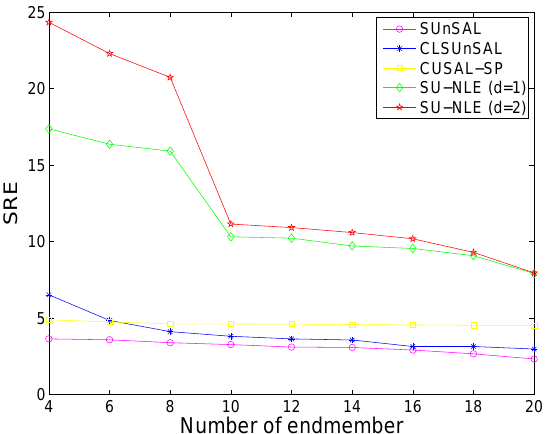
Figure 18. SREs of different methods as a function of varying number of endmember under correlated noise with only mixed regions having 64 × 64 pixels and 224 bands.